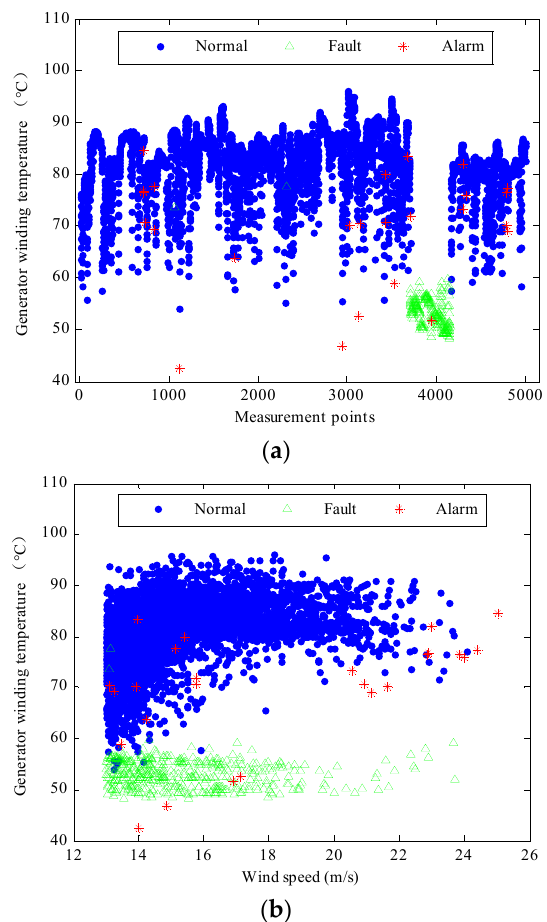
Figure 7. Generator winding temperature for fault detection: ( a ) Generator winding temperature against measurement time; ( b ) Generator winding temperature against wind speed.